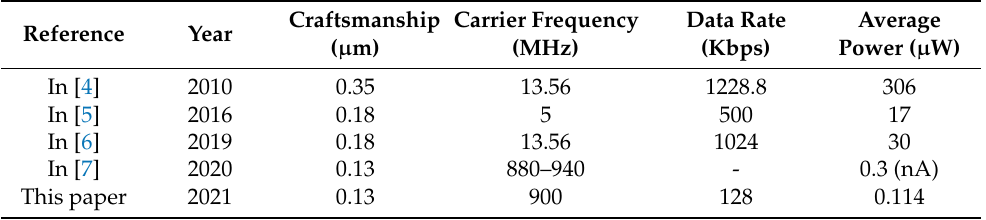
Table 1. Data comparison.